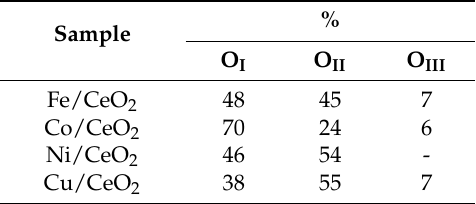
Table 3. Percentage of surface oxygen species on M/CeO 2 catalysts.